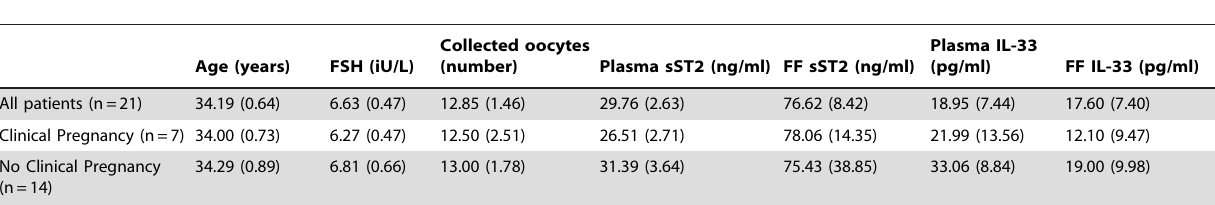
Table 1. Patient characteristics for women recruited to the Oxford Fertility Unit. Values are Mean